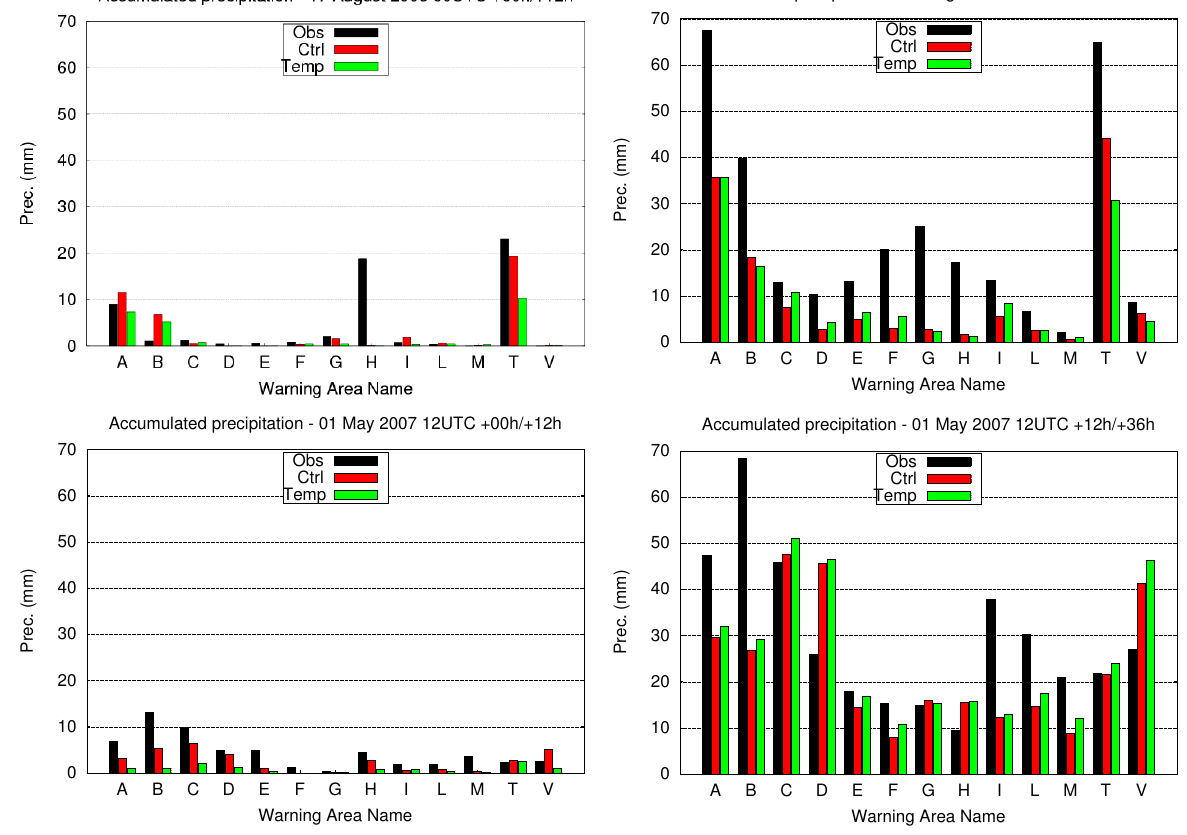
Fig. 18. Average precipitation amount over the Piemonte warning areas (A–M), including Ticino (T) and Valle d’Aosta (V). August 2006 (upper panels) and May 2007 (lower panels). Precipitation accumulated in the first 12h of the runs (left panels, assimilation period) and in the following 24h (right panels, free forecast). Comparison between Observations, Ctrl run and Temp run.